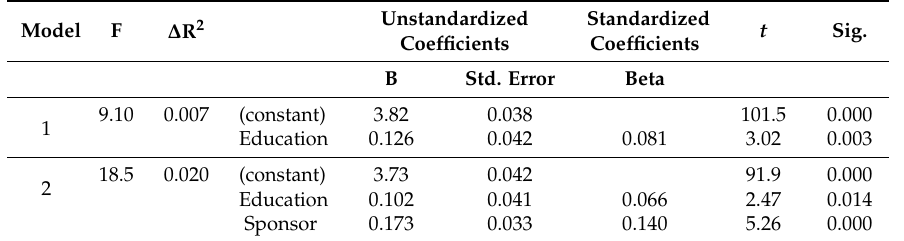
Table 7. Hierarchical Regression Coefficients.